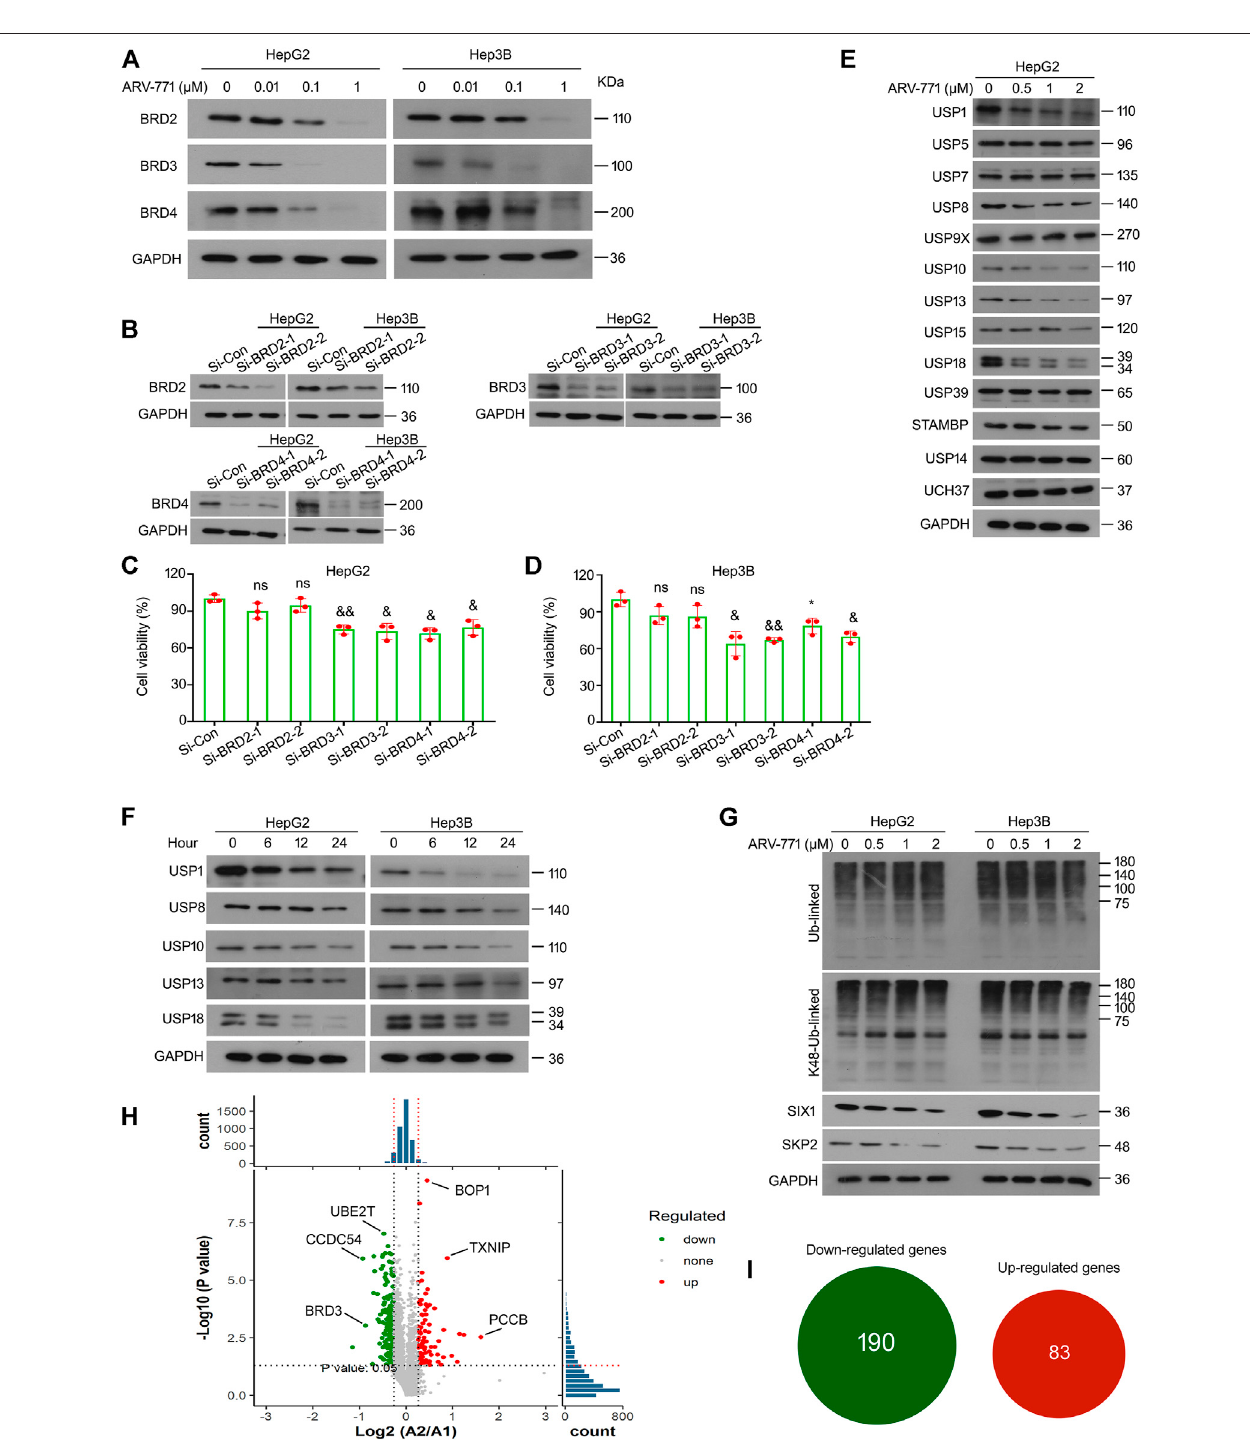
FIGURE4| ARV-771decreasesexpressionofmultipledeubiquitinasesinHCC cells. (A) ImmunoblotassaysforBRDswereperformed inHepG2andHep3B cells treatedwithARV-771(0.01,0.1,1 μ M)for24 h (B) HepG2andHep3BcellsweretransfectedwithBRDssiRNAorcontrolsiRNAfor48 h.ImmunoblotassaysforBRD2/ 3/4 were performed. (C) – (D) Cell viability assays were performed in HCC cells transfected with BRDs siRNA or control siRNA for 48 h * p < 0.05, & p < 0.01, && p < 0.001. (E) ImmunoblotassaysfortheindicateddeubiquitinaseswereperformedinHepG2cellstreatedwithARV-771(0.5,1,2 μ M)for24 h. (F) Immunoblotassaysforthe indicateddeubiquitinaseswereperformedinHepG2andHep3BcellstreatedwithARV-771(2 μ M)for6,12,and24 h. (G) Immunoblotassaysforpan-ubiquitinatedand Lys48-linked ubiquitinated proteins, SIX1, and SKP2 were performed in HepG2 and Hep3B cells treated with ARV-771 (0.5, 1, 2 μ M) for 24 h. (H) Quantitative volcano plot of the biological mass spectrometry performed in HepG2 cells treated with ARV-771 0.5 μ M or vehicle for 24 h. A2 represents ARV-771 treatment, while A1 represents the control group. (I) Numbers of Up/Down -regulated genes by the treatment of ARV-771.